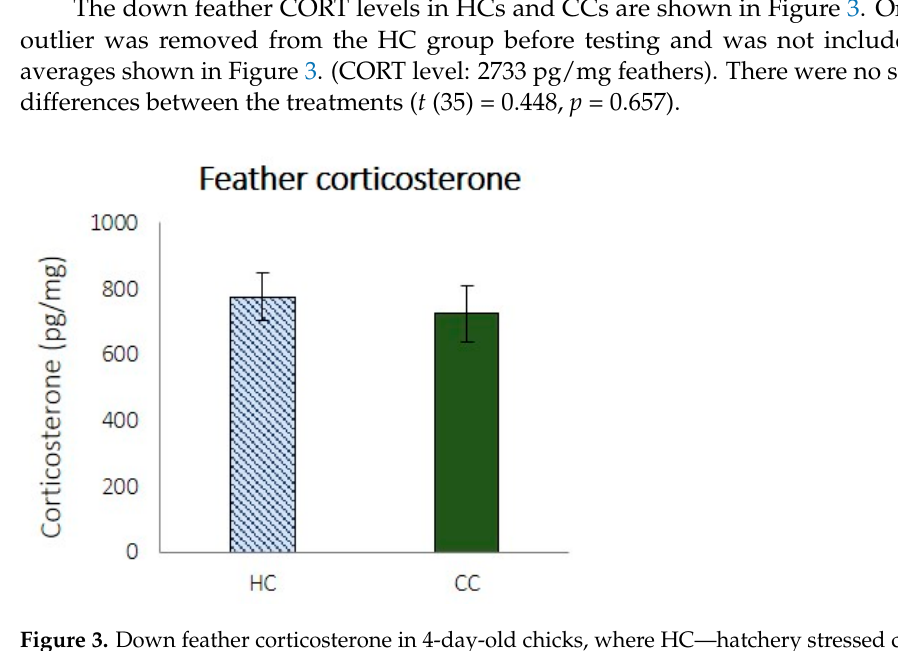
Figure 3. Down feather corticosterone in 4-day-old chicks, where HC—hatchery stressed chicks, and CC—control chicks.